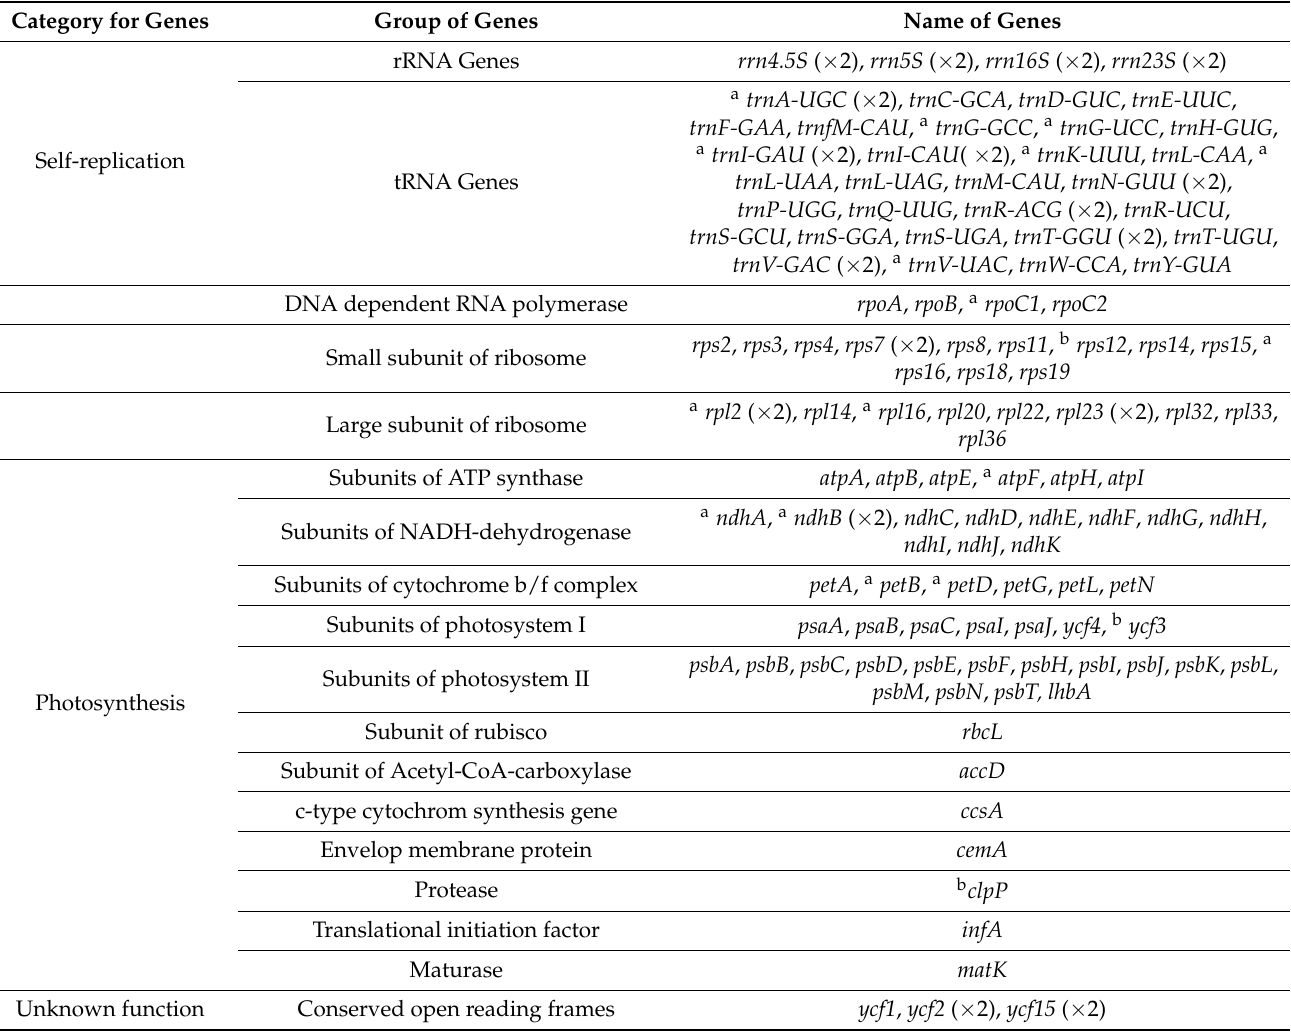
Table 2. Genes in the plastome of P. angulata var. villosa